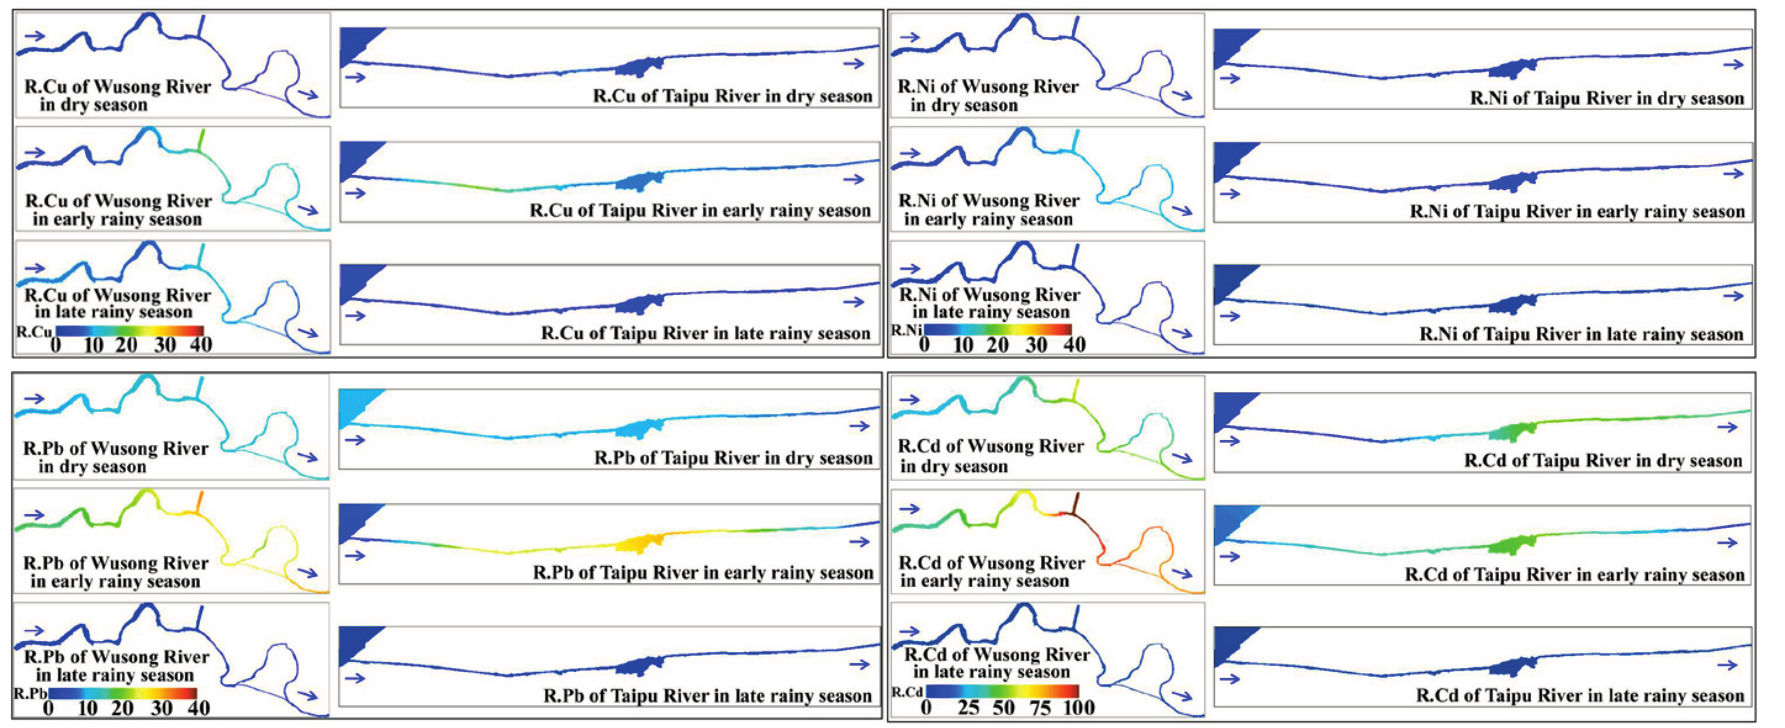
Figure 3. Seasonal and spatial distribution of pollution risk on Cu, Ni, Pb and Cd in the two